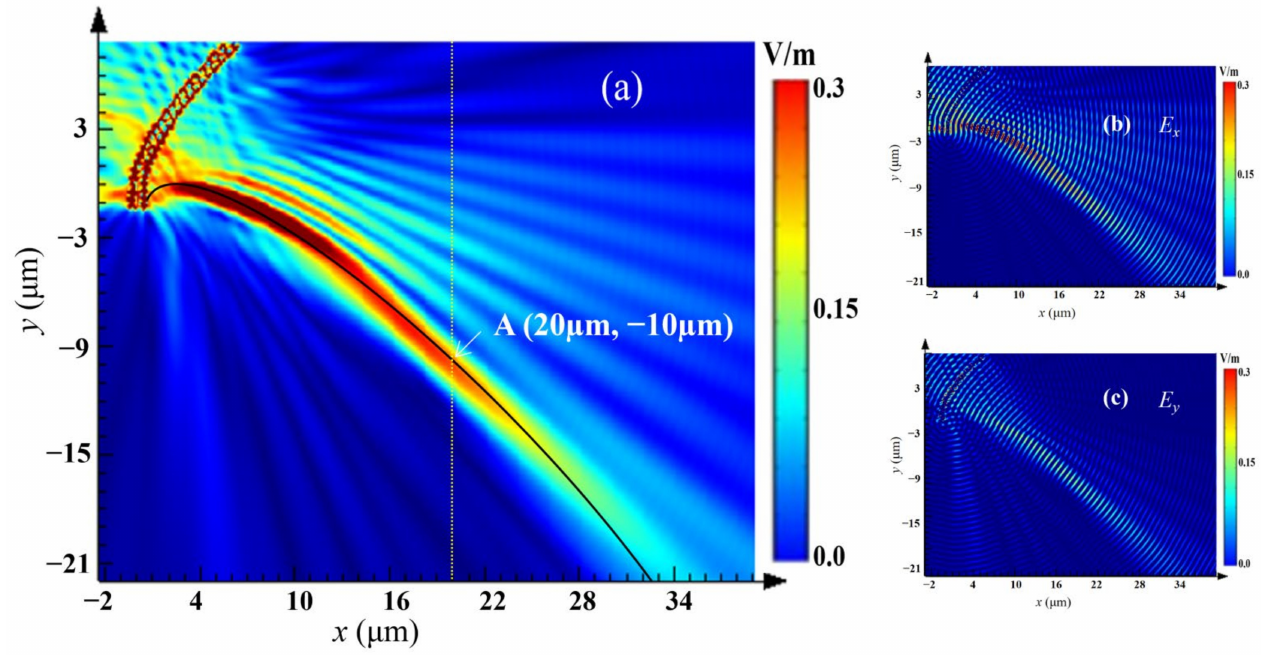
Figure 3. Electric field intensity distribution in the polarization angle γ = 0 ◦ , b = 0.6 µ m, and a L = a R = 0 µ m; ( a ) electric field norm, ( b ) electric field x component and ( c ) electric field y